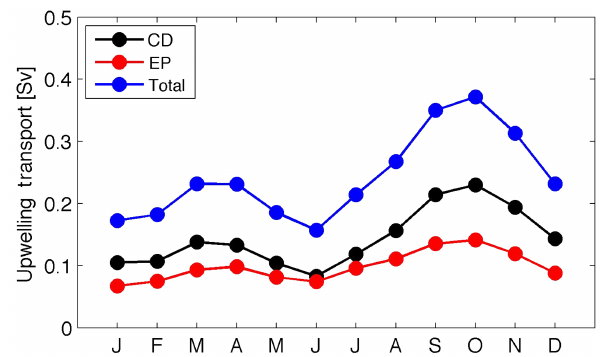
Figure 8. Contributions of coastal divergence (CD) and Ekman pumping (EP) to the vertical transport near the coast (inSv) over the study area (27.75–32.5 ◦ S, see Fig. 7). Seasonal vertical transport associated with coastal divergence (black line), Ekman pumping (red line) and total wind induced vertical transport (blue line, sum of both vertical transports). The estimates were carried out from the WRF simulation at 4km resolution.